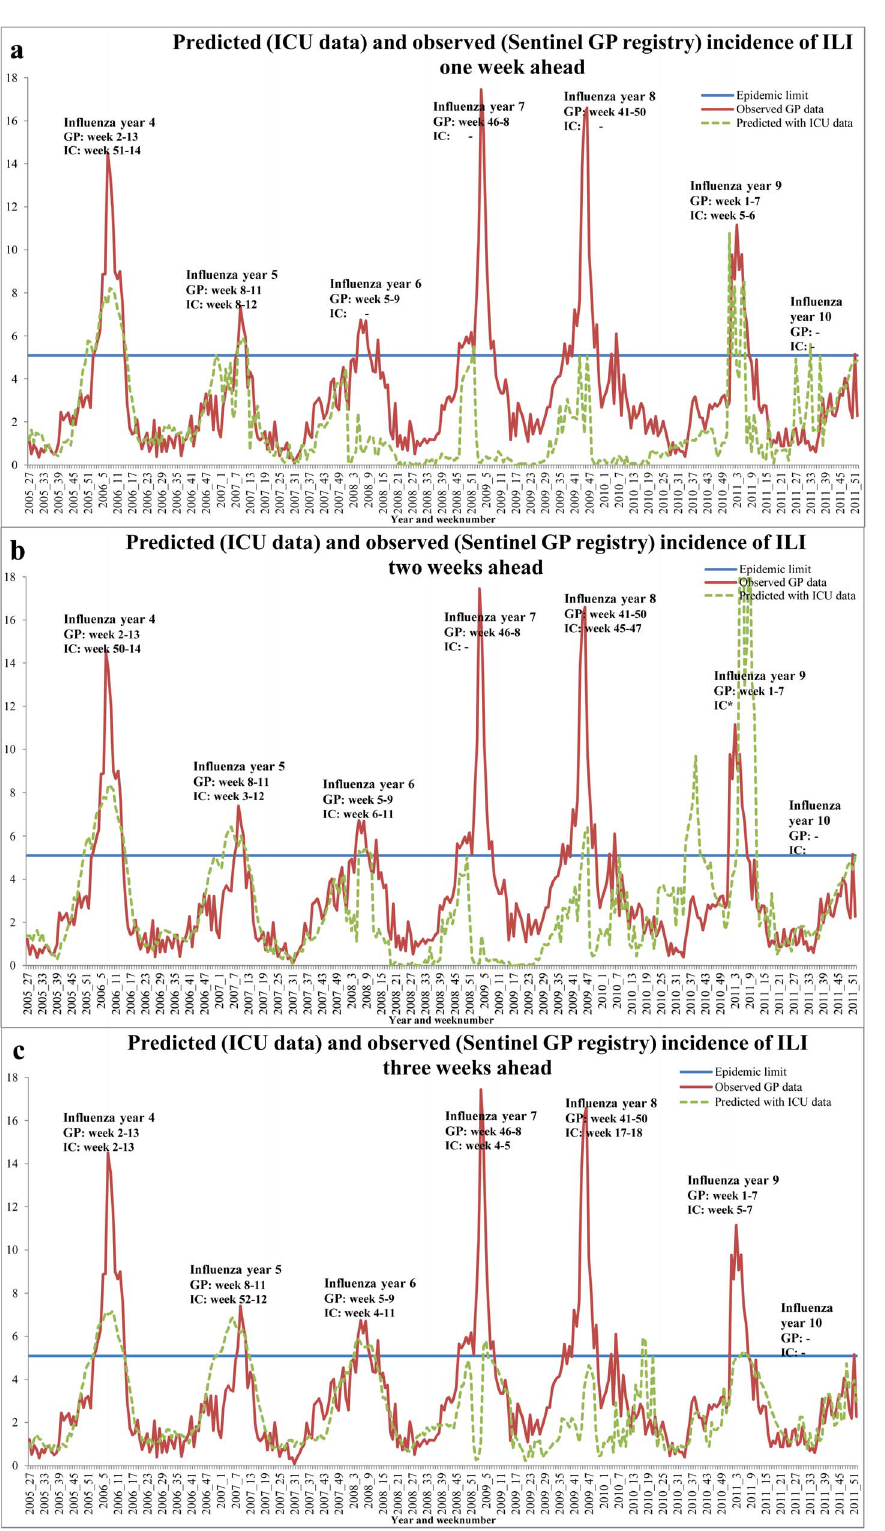
Figure 2. Observed incidence of Influenza Like Illness (ILI) according to the Sentinel General Practitioners registry (sentinel GP registry) and predicted according to Intensive Care Unit (ICU) data. Weeks where an influenza epidemic was detected are also shown. Figure (a), (b), and (c) predict one to three weeks ahead. Weeks marked with an *-sign indicate multiple detections of an influenza epidemic in one influenza year.